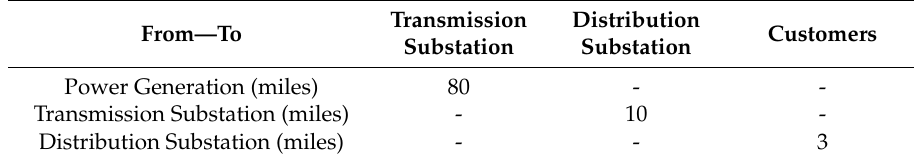
Table 3. The Network Data for Power Generation, and Transmission and Distribution